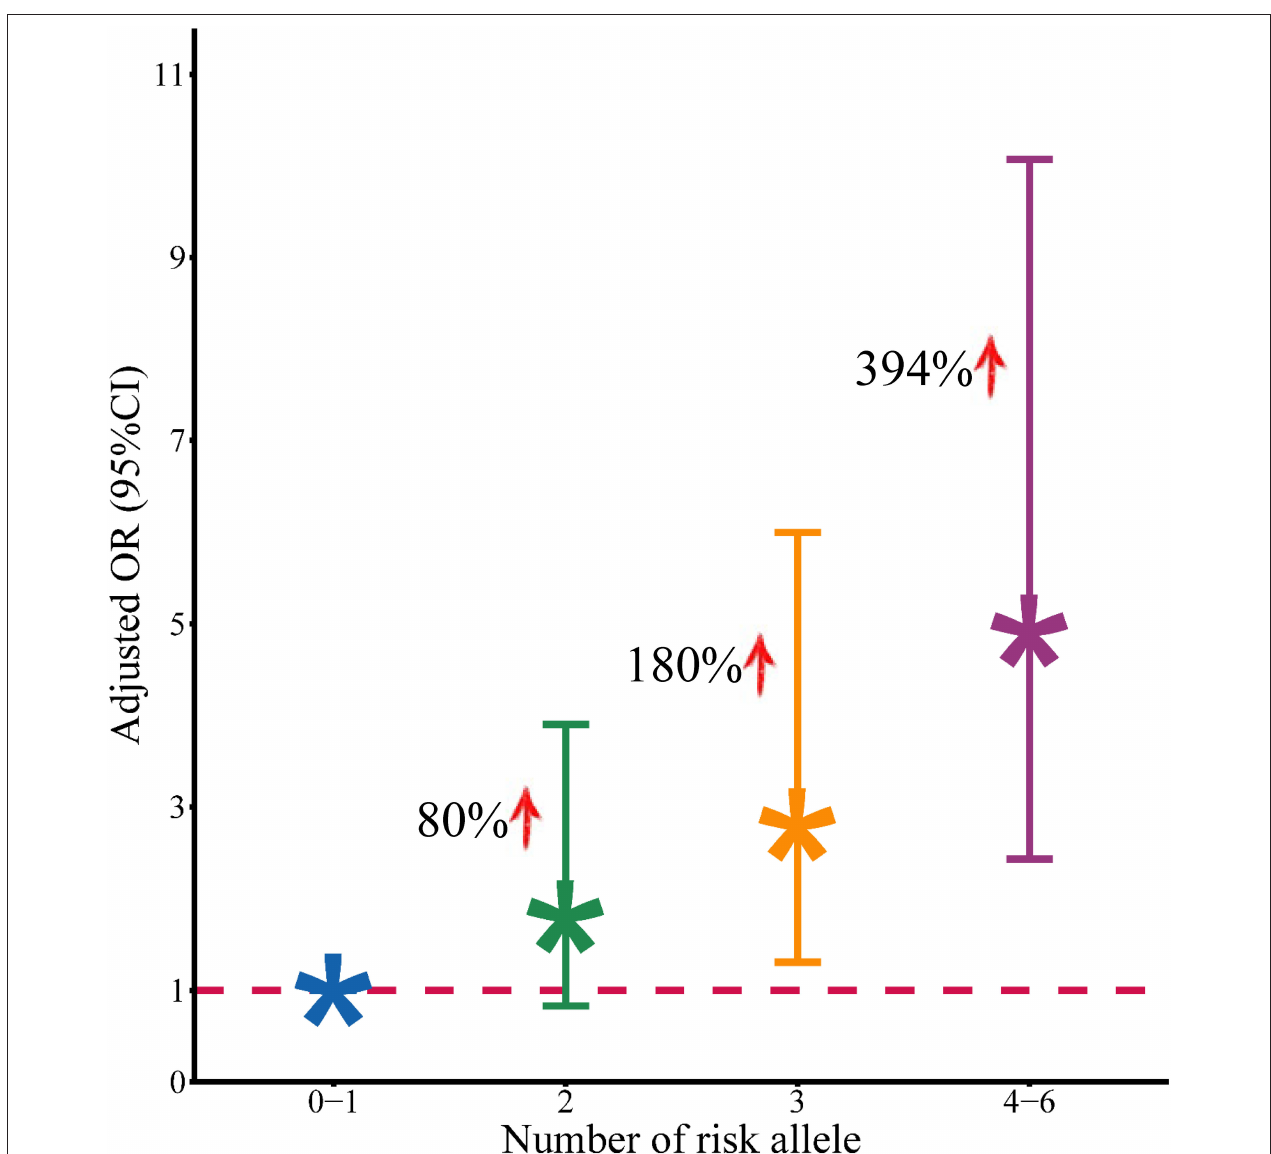
FIGURE 3 | Association between the number of risk alleles of positive SNPs and the risk of development of